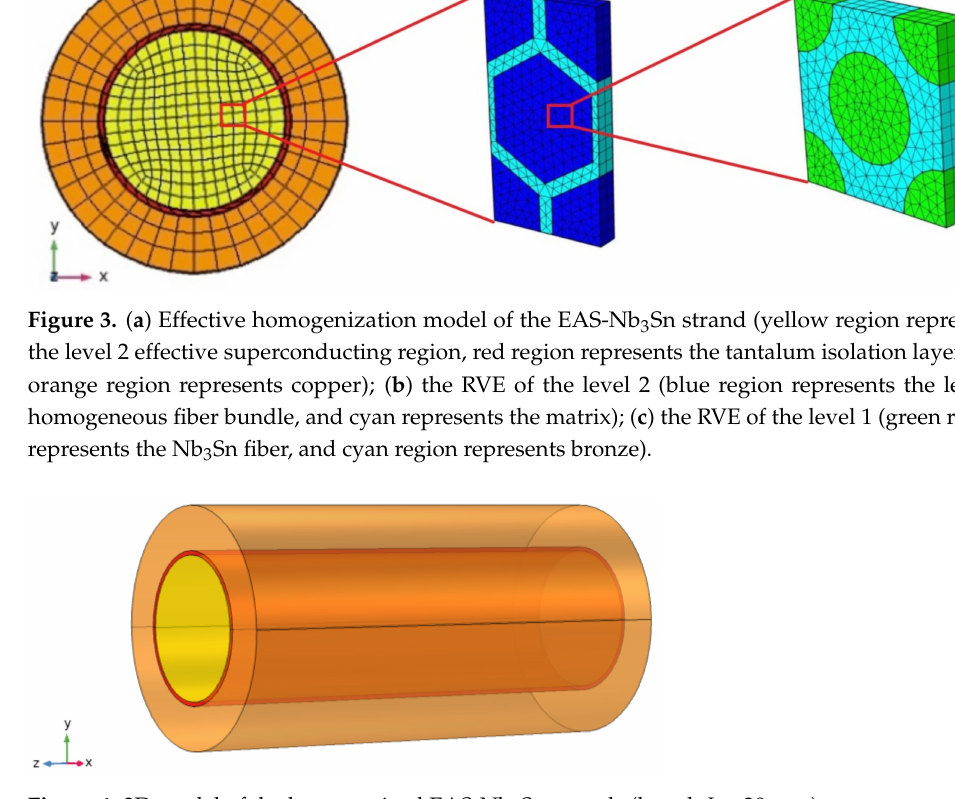
Figure 4. 3D model of the homogenized EAS-Nb 3 Sn strands (length L = 20